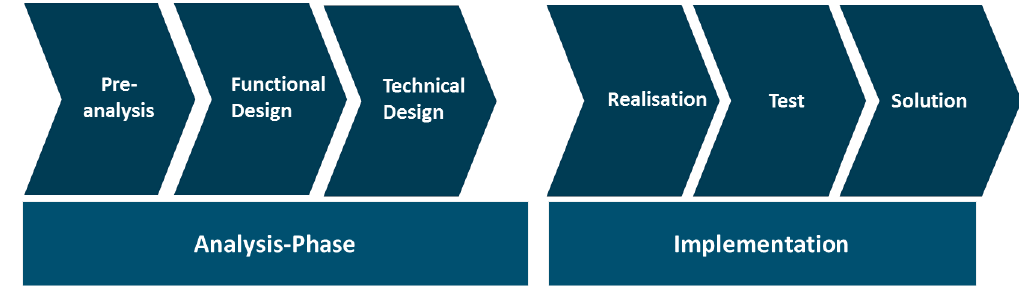
Figure 2. The different stages of